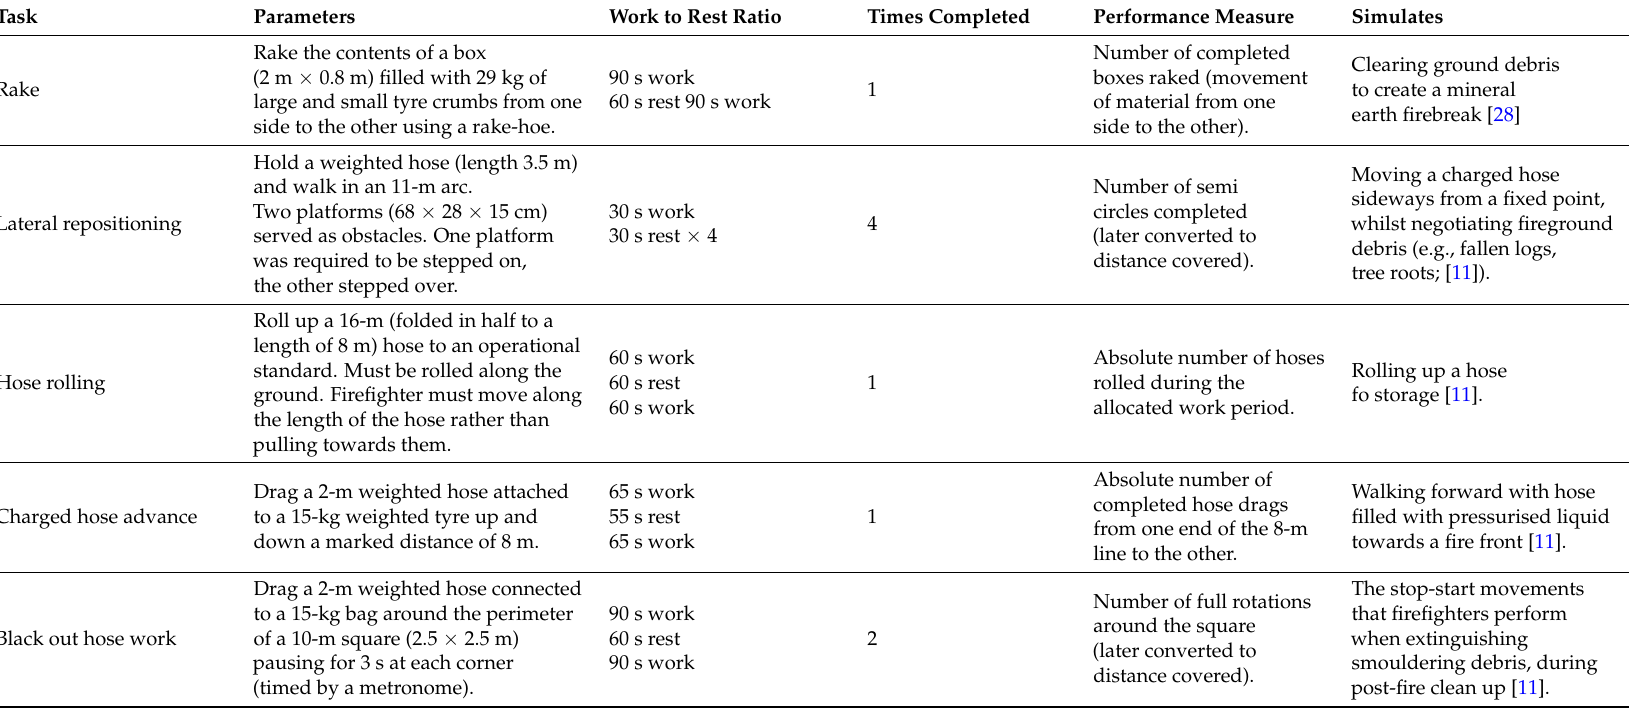
Table 2. Physical work circuit